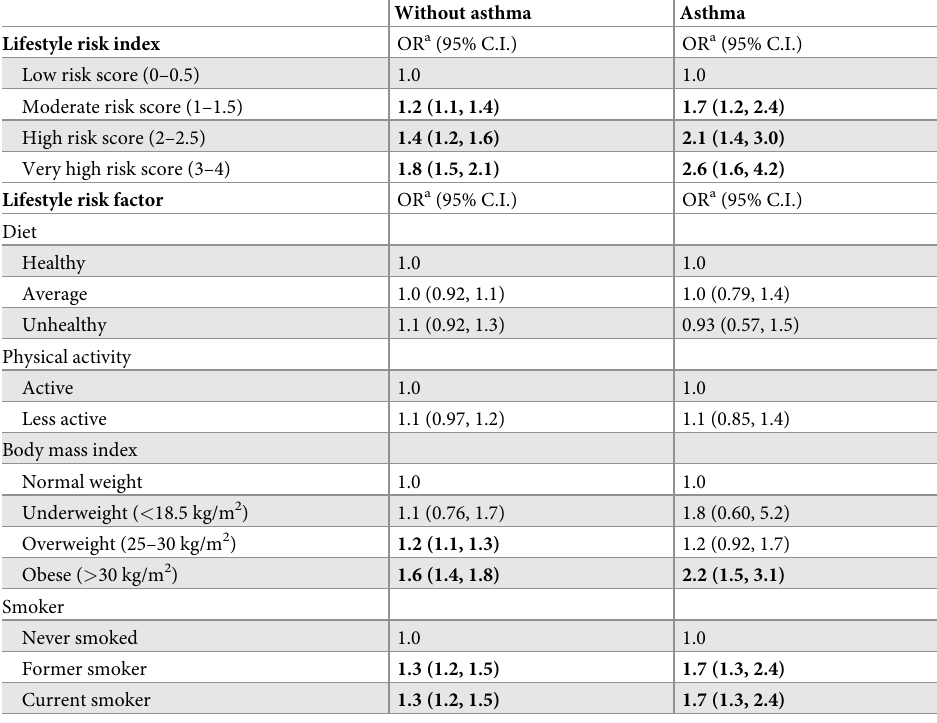
a Adjusted for gender, age, educational level and other chronic lung